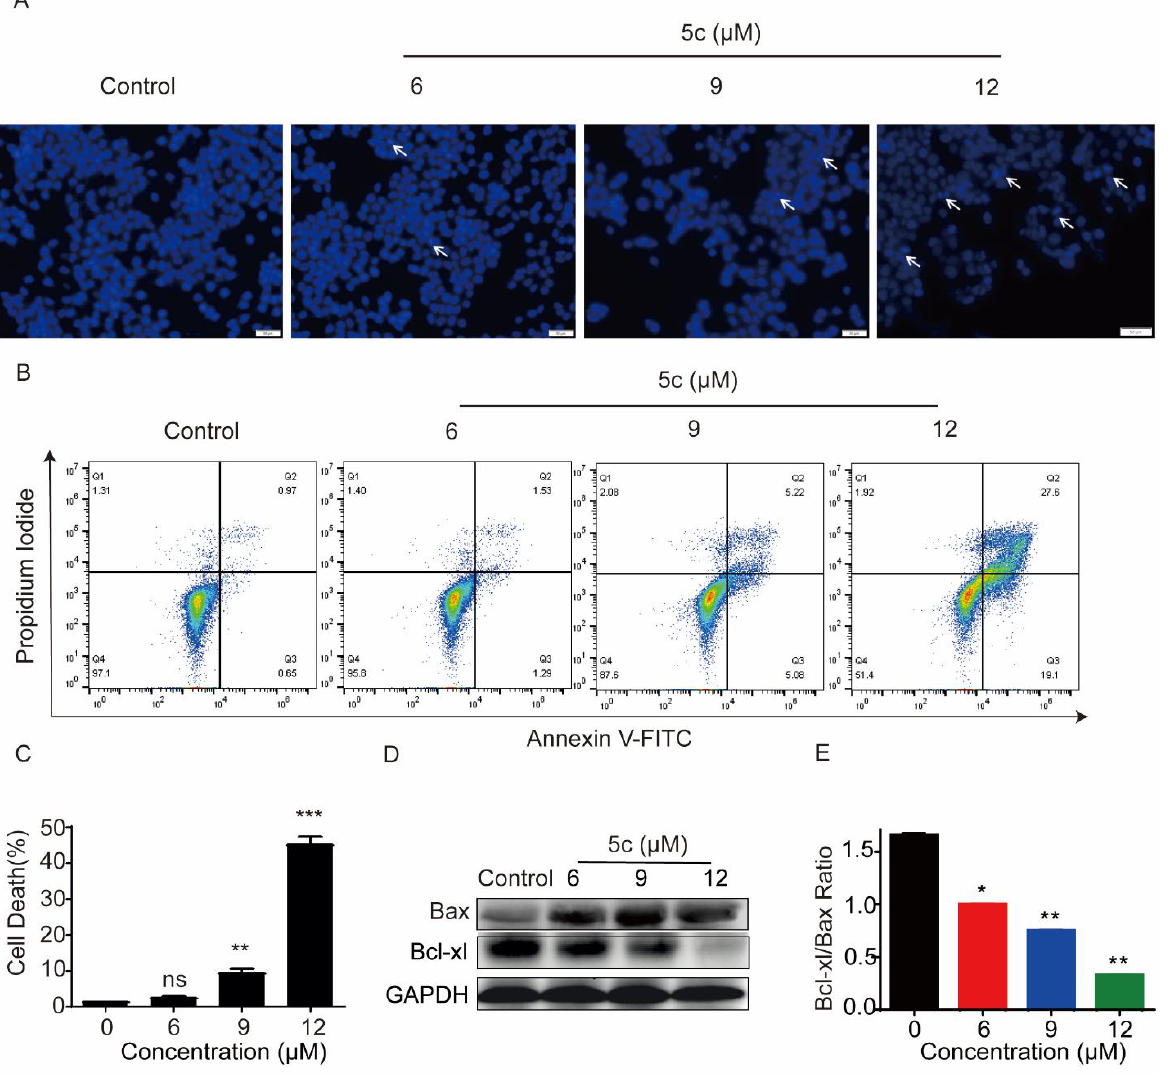
Figure 8. Compound 5c -induced tumor cell apoptosis in vitro. ( A ) After being treated with com- pound 5c (6–12 µ M), cells were fixed and stained with Hoechst 33342 and observed under a flu- orescence microscope. Apoptotic bodies are indicated by white arrows. ( B ) After treatment with compound 5c (6–12 µ M), the cells were analyzed using flow cytometry. ( C ) Quantitative statistics of the results in ( B ) using GraphPad Prism 8.0 software. ( D ) Levels of Bcl-xl and Bax after treatment with compound 5c (6–12 µ M) for a 24 h interval. GAPDH was used as a control. ( E ) Quantitative statistics of the results in ( D ) using ImageJ 1.8.0 software. Values are presented as the means ± SDs from three independent experiments. ns = not significant, * p < 0.05, ** p < 0.01, *** p <